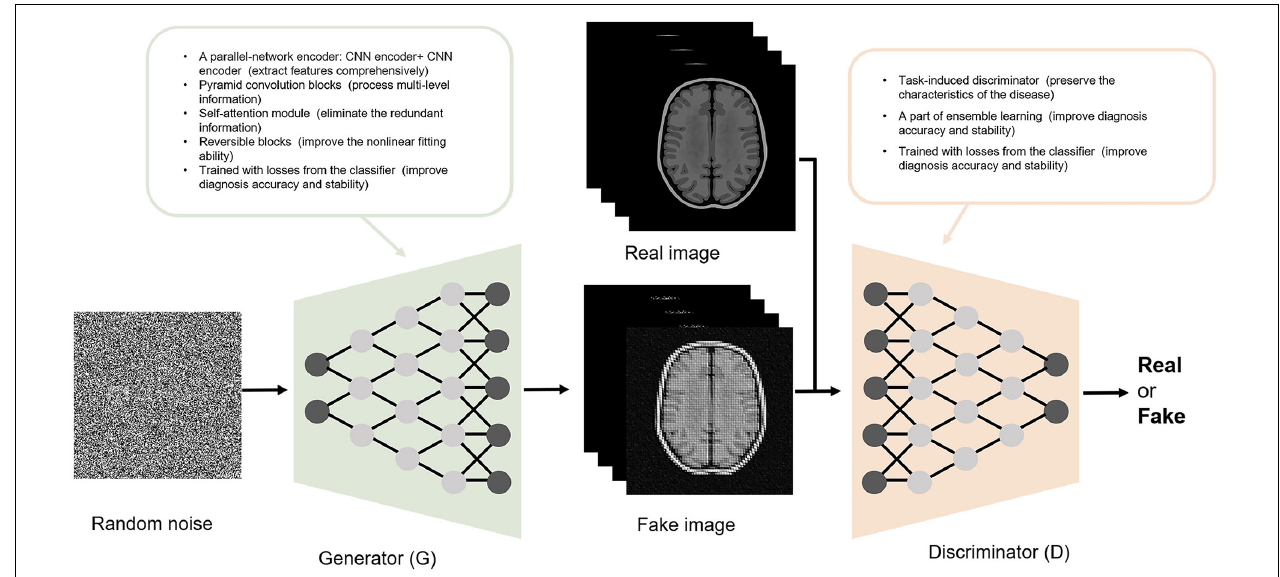
FIGURE 3 | The structure of the GAN and some improvements reported in the included